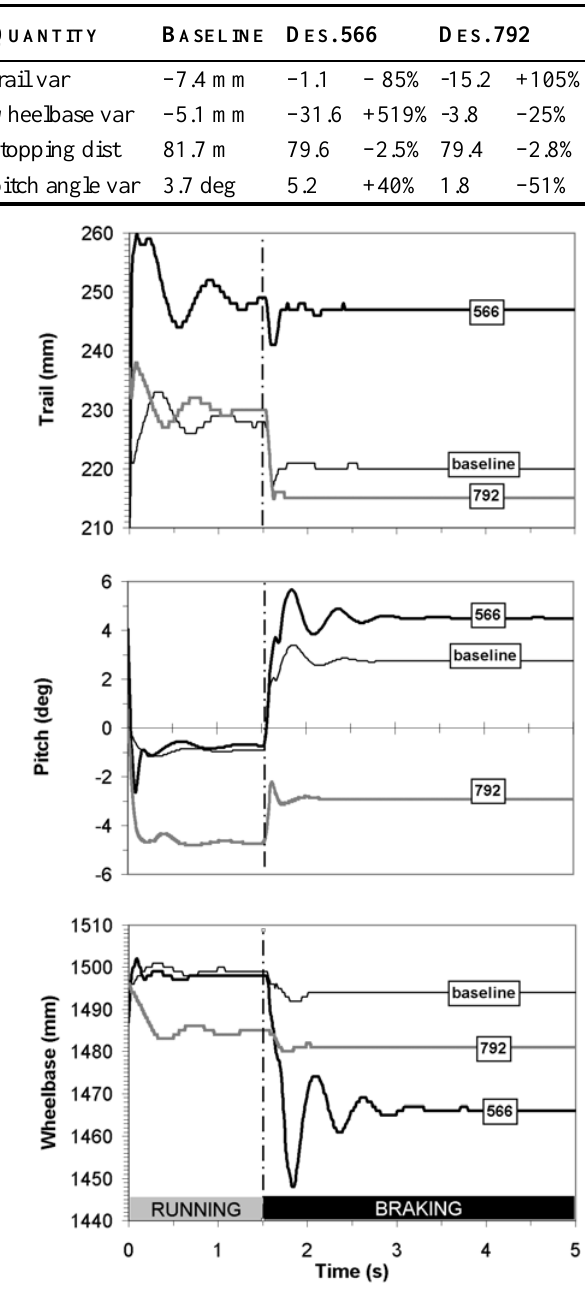
Fig. 10 Comparison between baseline and both optimized